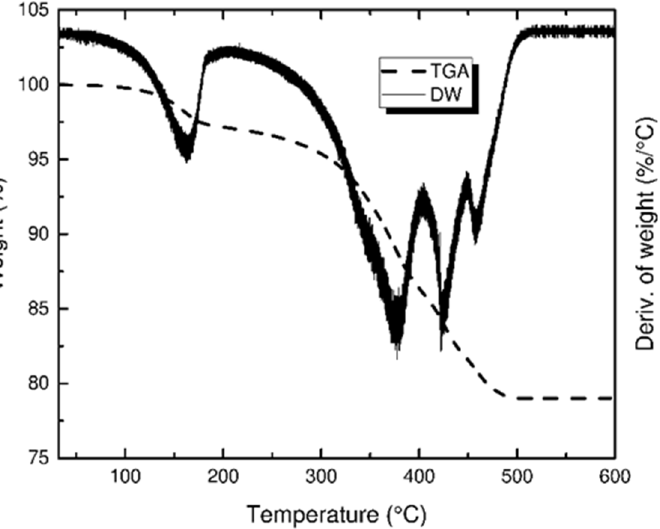
Figure 6. Thermogravimetric analysis representing both weight change percent and the rate of change in weight vs. temperature in an argon atmosphere.